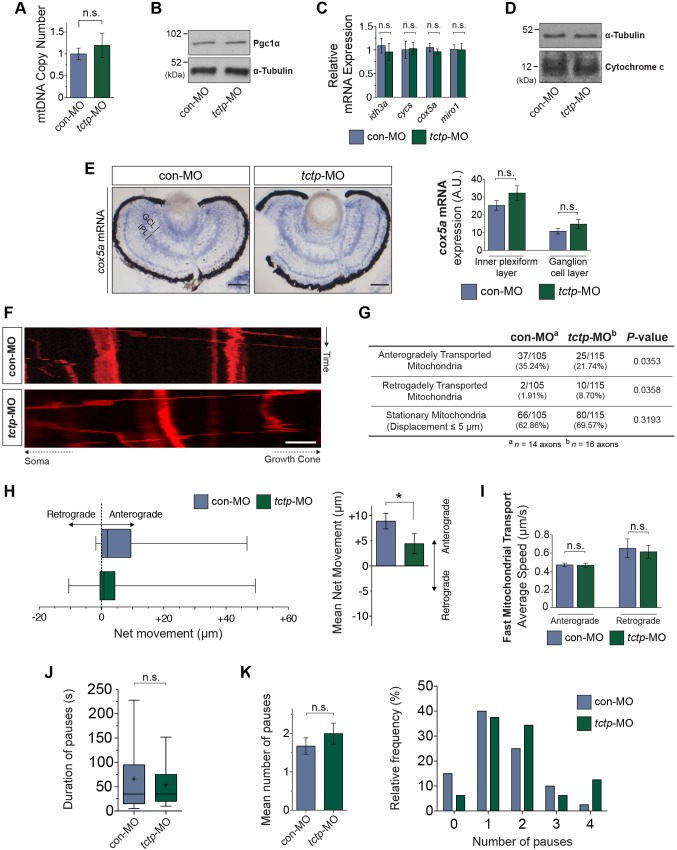
Altered mitochondrial dynamics in Tctp-depleted axons. (A) Ratio of mitochondrial to nuclear DNA determined by qPCR in control and Tctp-depleted retinas. Mean±95% confidence interval; n=7 paired retinas per condition; P=0.23, Mann–Whitney test. (B) Tctp morphants show unaltered Pgc1α expression levels in the CNS as evaluated by western blot analysis of stage 37/38 embryos using an anti-Pgc1α antibody. n=3 independent samples; P=0.5955, unpaired t-test. (C) Tctp morphants show unaltered expression of mitochondria-related genes as assessed by RT-qPCR using eye RNA extracts. Mean±95% confidence interval; n=9 retinas per condition, Mann–Whitney test. (D) Tctp morphants show unaltered cytochrome c expression levels in the CNS, as evaluated by western blot analysis of stage 37/38 embryos using an anti-cytochrome c antibody. n=3 independent samples; P=0.5989, unpaired t-test. (E) Control and Tctp-depleted RGCs have similar levels of cox5a expression. Mean±s.e.m.; n=∼20. GCL, P=0.2026; IPL, P=0.2668; Mann–Whitney test. (F) Representative kymographs (time-space plots) of MitoTracker-labelled RGC axonal mitochondria in control and Tctp morphant backgrounds. The vertical and horizontal axes represent time and spatial position, respectively (e.g. a vertical line indicates a stationary mitochondrion). (G) Summary of changes in axonal mitochondrial dynamics (statistical significance determined using Fisher's exact test). (H) Relative mitochondrial motility and mean net movement in control and Tctp-depleted RGC axons. Box plot whiskers indicate 5th-95th percentile. Right: Mean±s.e.m.; *P<0.0117, Mann–Whitney test. (I) Analysis of fast mitochondrial transport. Mean±s.e.m.; anterograde direction, P=0.9468; retrograde direction, P=0.7308; Mann–Whitney test. (J) Average duration of mitochondrial pauses in control and Tctp-depleted RGC axons. Box plot whiskers indicate 5-95 percentile and ‘+’ the mean; P=0.902, Mann–Whitney test. Permanently stationary mitochondria were excluded from this analysis. (K) Average number and frequency distributions of mitochondrial pauses. Mean±s.e.m.; P=0.317, Mann–Whitney test. Scale bars: 50 μm in E; 5 μm in F. n.s., not significant.